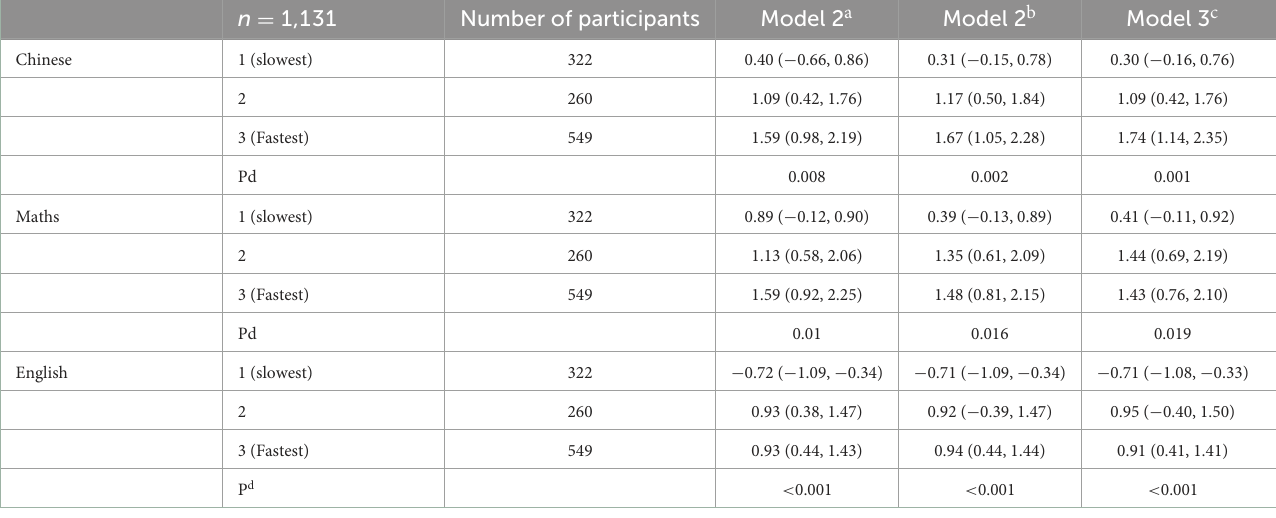
TABLE 6 Multivariable-adjusted relationships of 1-min jump rope with change in academic performance during the 3-year follow-up period. n =